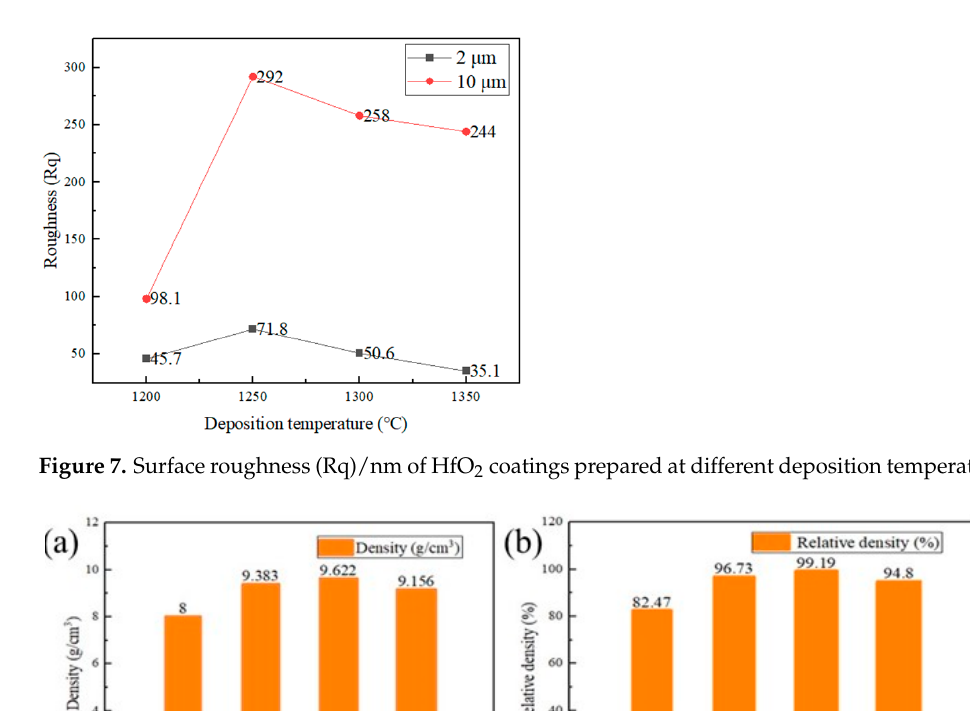
10 of 16 Figure 6. AFM images of HfO 2 coatings prepared at different deposition temperatures. ( a ) 1200 °C; ( b ) 1200 °C; ( c ) 1250 °C; ( d ) 1250 °C; ( e ) 1300 °C; ( f ) 1300 °C; ( g ) 1350 °C; ( h ) 1350 °C. It can be seen from Figure 7 that the deposition surface roughness increases first and then decreases with an increase in the deposition temperature and reaches a maximum at 1200 °C. The reason for this phenomenon is that when the deposition temperature is low, the HfO 2 particles cannot grow up due to insufficient temperature, and the particle size is uniform, so the roughness is small. When the temperature rises to 1250 °C, the particles begin to grow, and the roughness increases and reaches a peak. When the temperature continues to rise to 1300 °C, the particles continue to grow, but the roughness decreases. At 1300 °C, because the particles grow more uniformly than at 1250 °C, it can also be seen from the AFM image that the HfO 2 coating particles are more complete and uniform at